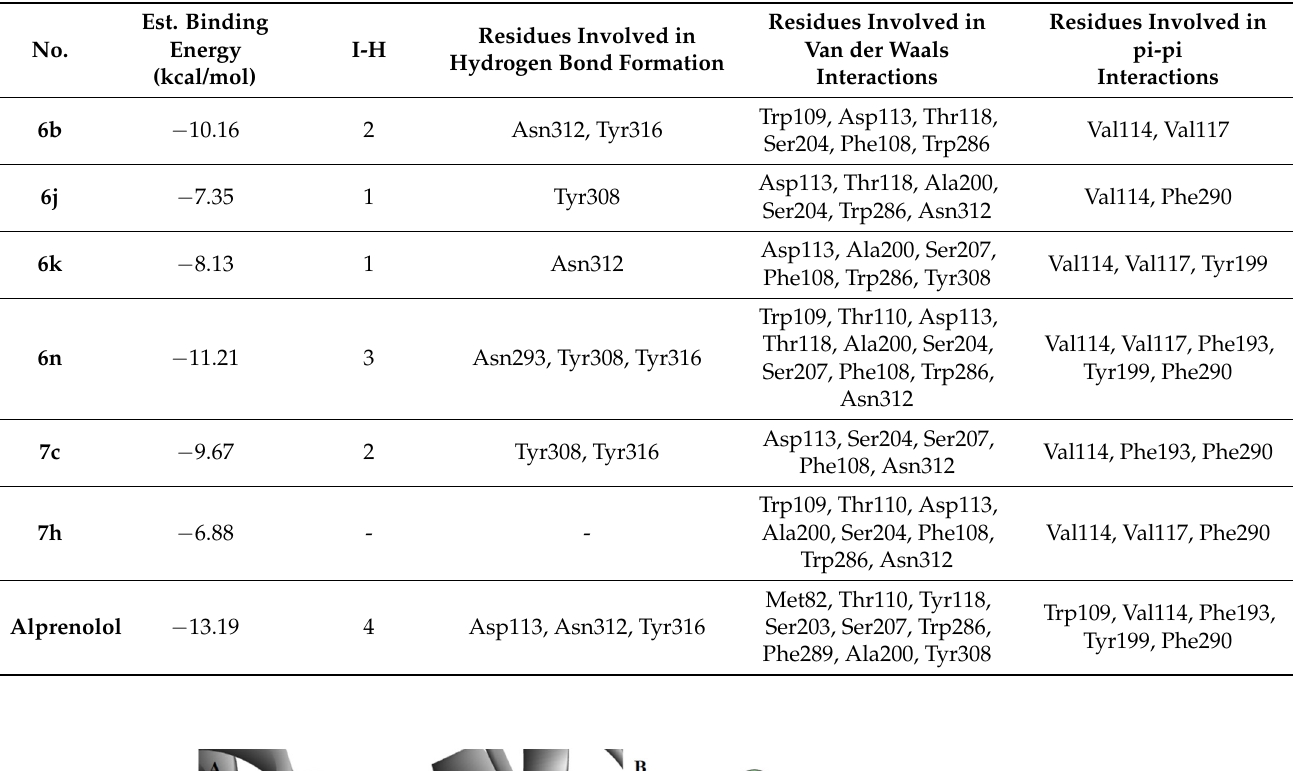
Table 9. Molecular docking free binding energies (kcal/mol) in 5-HT 1A receptor (PDB ID: 3NYA).